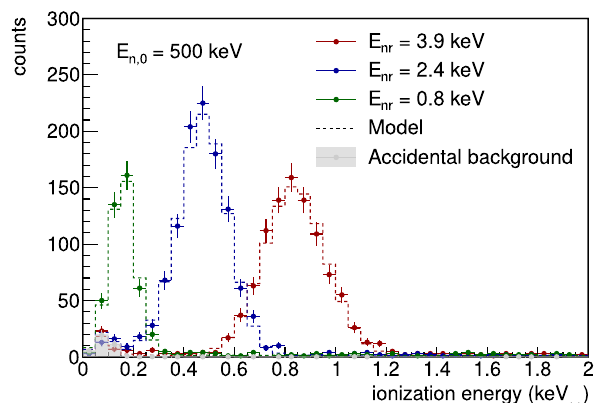
Fig. 13 Coincidence energy distribution obtained in the HPGe detec- tor after coincidence selection E nr = 0.4 keV nr (blue) along with the estimated accidental contribution (gray). The upper limit at 90% C.L. corresponds to a quenching factor of 0.28 and the corresponding expec- tation is shown as dashed red